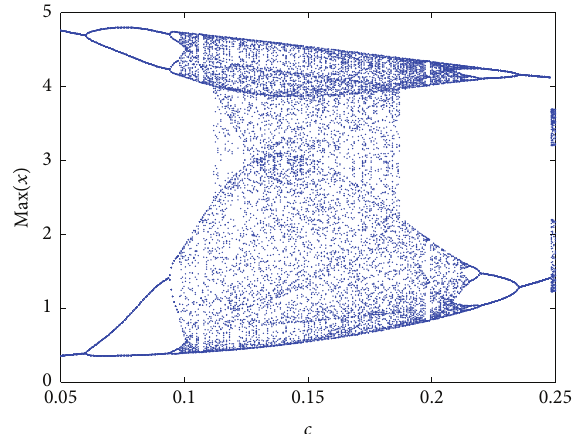
Figure 7: The bifurcation diagram of system (7) in plane (𝑐, 𝑥) when 0.05 ⩽ 𝑐 ⩽ 0.25 , 𝐴 = 0.12 , 𝑚 = 0.3 , 𝑏 = 0.2 , 𝑑 = 0.8 , 𝛽 = 2.4 , 𝛼 = 1.7 , ℎ = 1.2 , and 𝜔 = 0.6 .